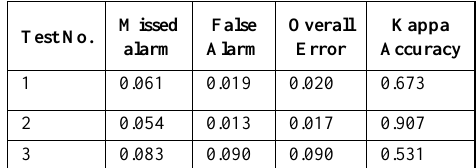
Table 2. Result evaluation of 3 selected deforestation